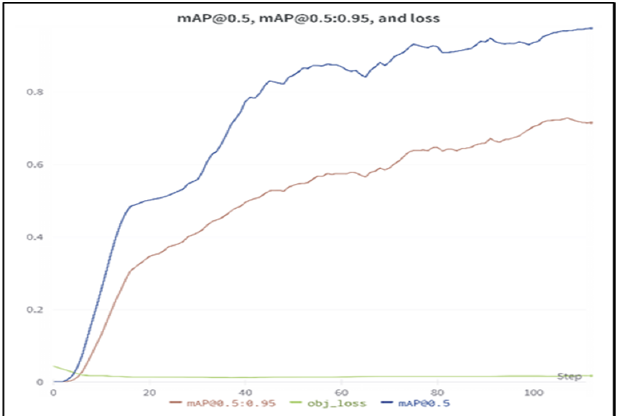
Figure 4. Mean Average Precision and Average Loss of Transfer Learning of Yolo with respect to Training Epochs.